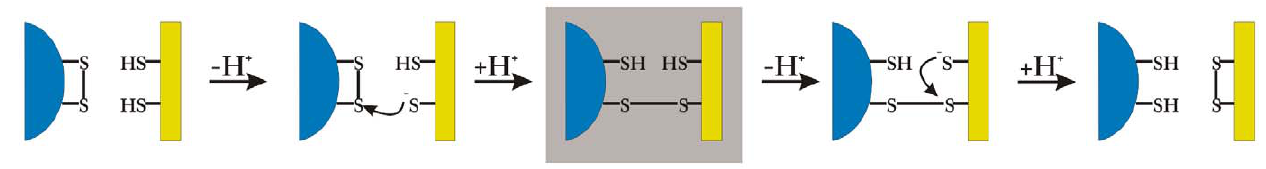
Figure 3. Basic mechanism for disulfide oxidation catalyzed by a thioredoxin-fold domain. (Thioredoxin domain shown in blue). The mixed disulfide intermediate has been highlighted in grey. Note that, unlike the mechanism of disulfide reduction shown in Figure 2, resolution of the intermediate occurs through attack of a thiolate group of the substrate. Actually, attack of the thiolate from the catalyst (as in Figure 2) must be prevented since it would revert the substrate to the initial reduced state.